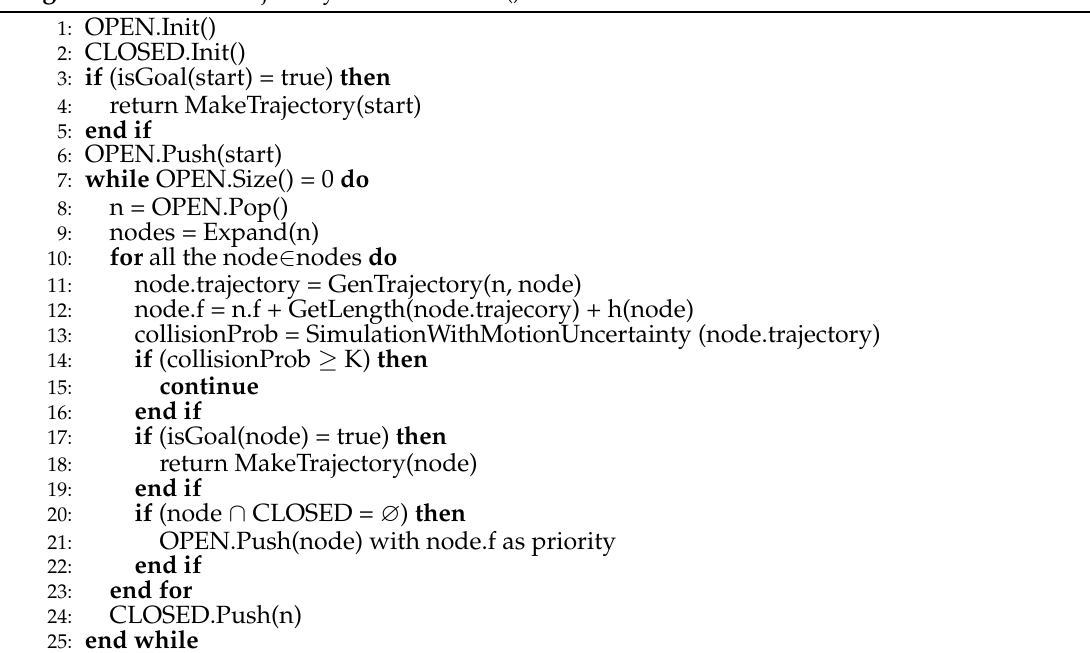
Algorithm 2: MakeTrajectoryBasedOnAStar ().